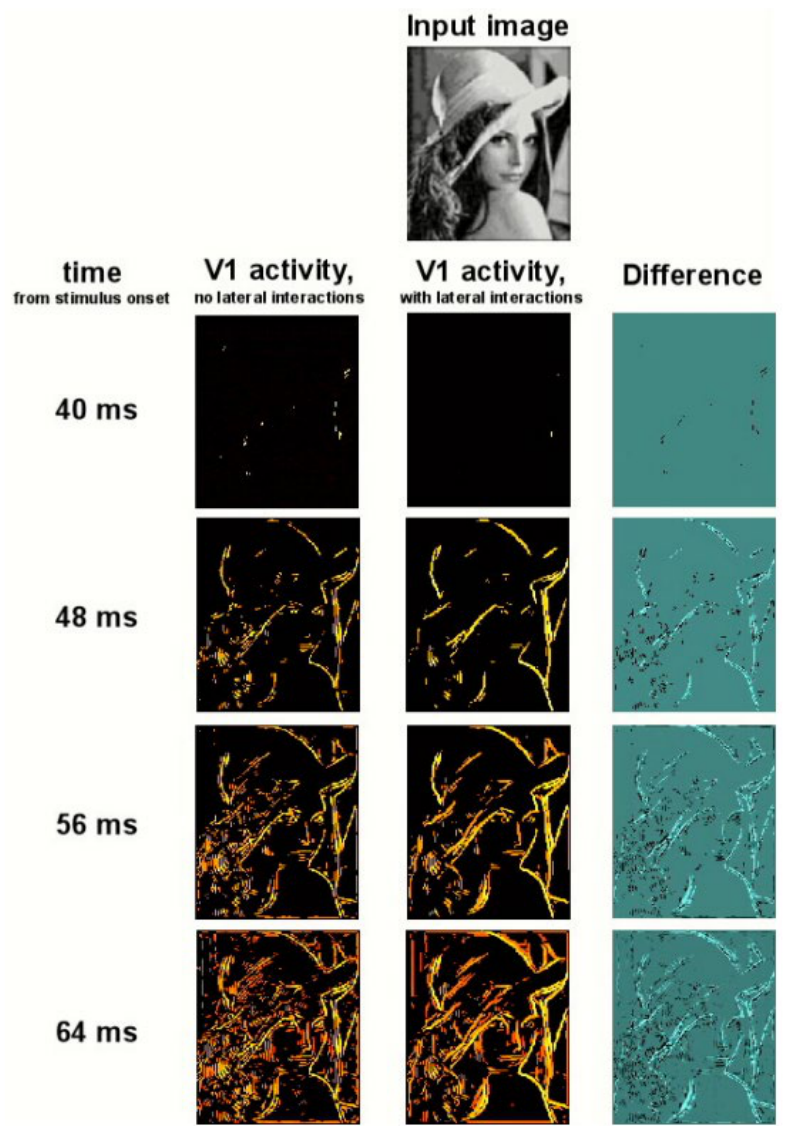
Figure 28. Example of contour integration for a natural input image. The contour integration is employed with edge extraction from the primary visual cortex (V1).